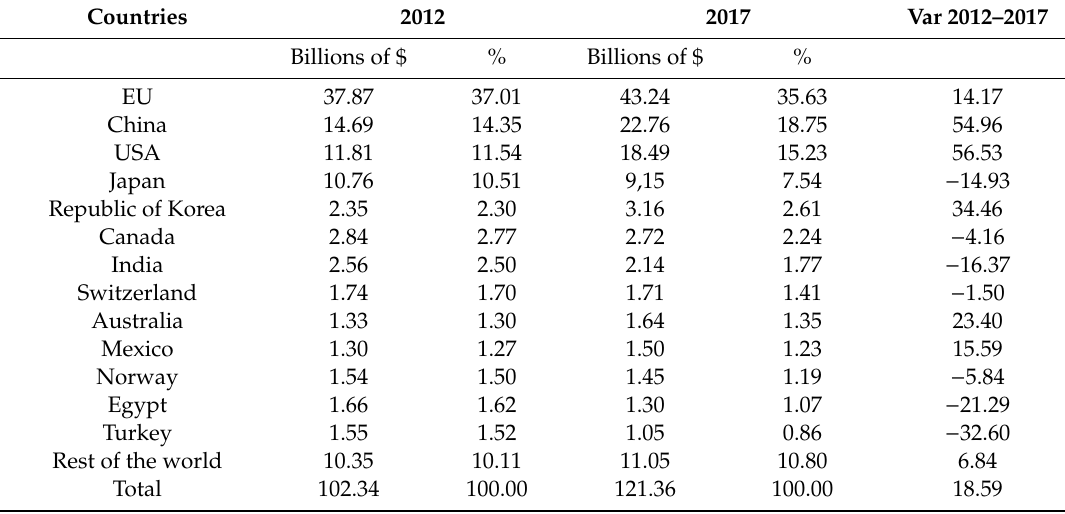
Table 3. Distribution of world imports of timber and timber products by country groups and countries in 2012 and 2017 and variations over the period 2012–2017 (%).